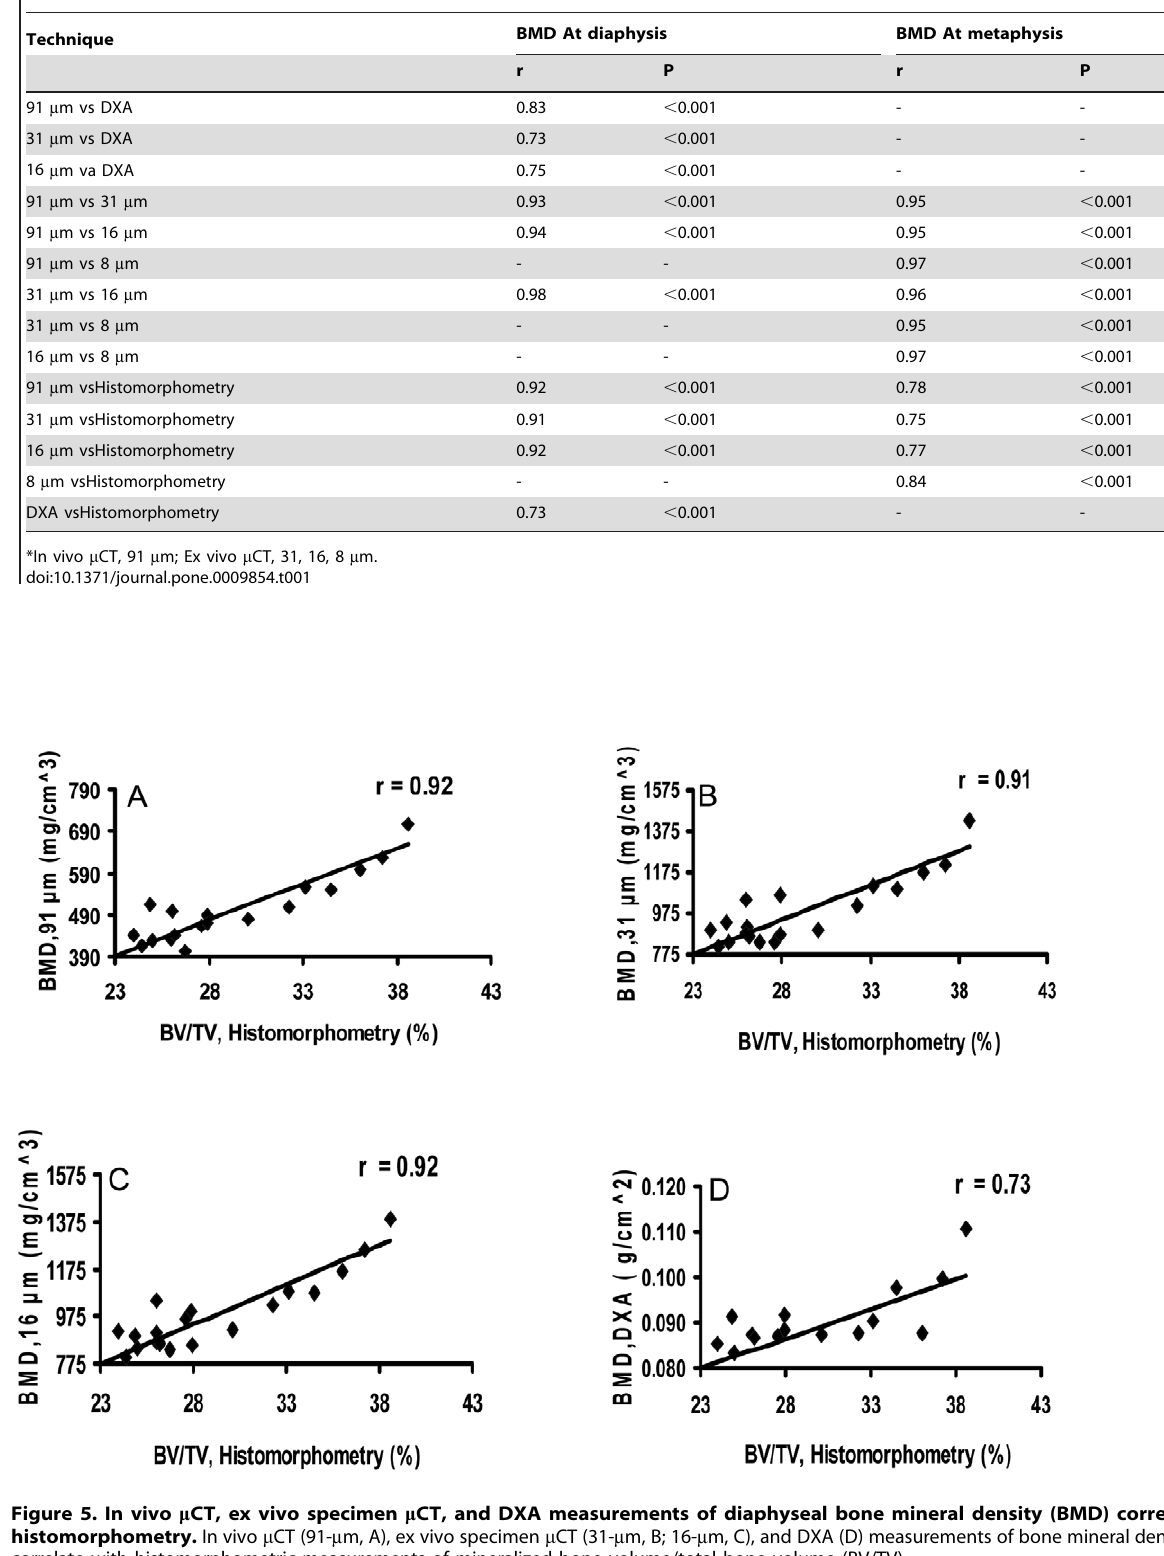
Table 1. Correlations between diaphyseal or metaphyseal BMD determined by bone histomorphometry and in vivo m CT, ex vivo specimen m CT or ex vivo DXA 10 weeks after tumor inoculation.